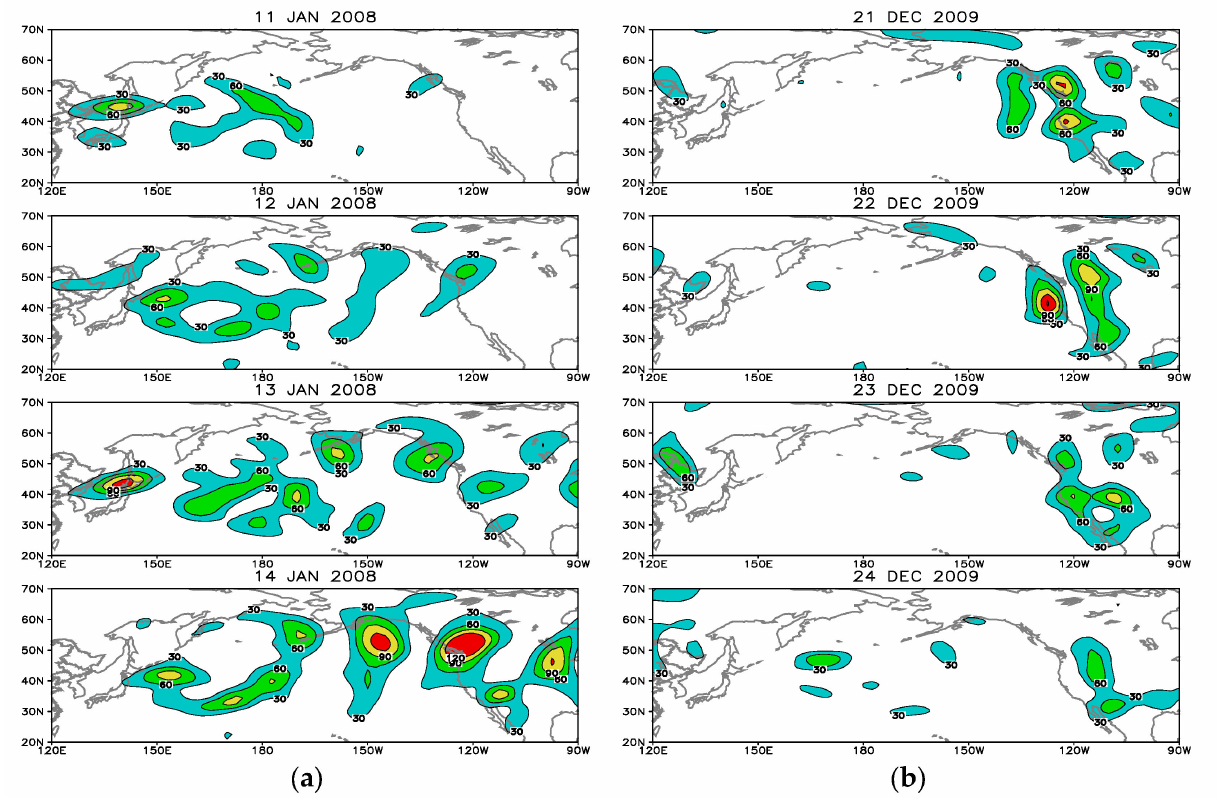
Figure 7. Distribution of synoptic disturbance kinetic energy in 500 hPa with a contour interval of 30 m 2 · s − 2 from ( a ) 11–14 January 2008; ( b ) 17–19 December